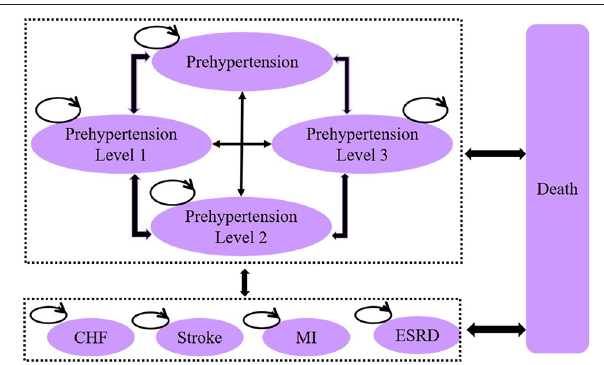
FIGURE 1 | Schematic diagram showing health-state transition in the Markov model for hypertension. (1) Prehypertension: systolic blood pressure (SBP) = 120–139, diastolic blood pressure (DBP) = 80–89; (2) Hypertension-L1: SBP = 140–159, DBP = 90–99; (3) Hypertension-L2: SBP = 160–179, DBP = 100–109; (4) Hypertension-L3: SBP ≥ 180, DBP ≥ 110; (5) MI: myocardial infarction; (6) CHF: congestive heart failure; (7) ESRD: end-stage renal